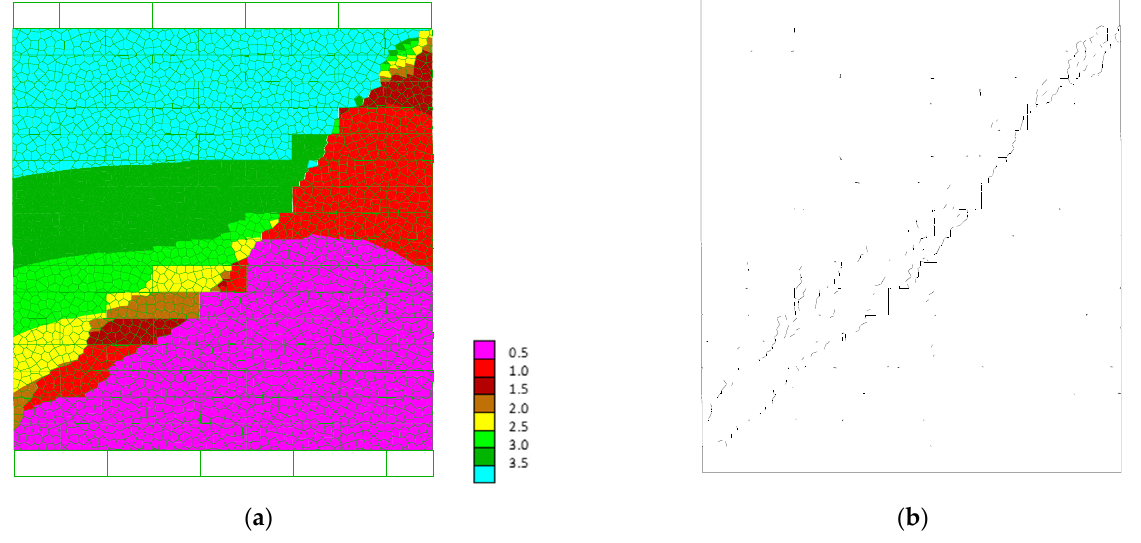
Figure 19. Failure mode of shear panel test with vertical stress of 2.12 MPa. ( a ) Contours of horizontal displacement (in mm); ( b ) Distribution of cracked joints and inner-brick cracks.